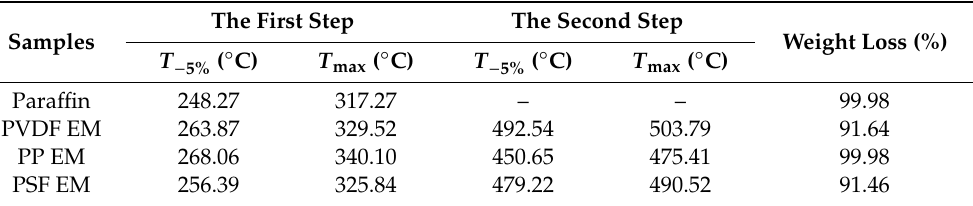
Table 4. Summary of the thermal degradation data.